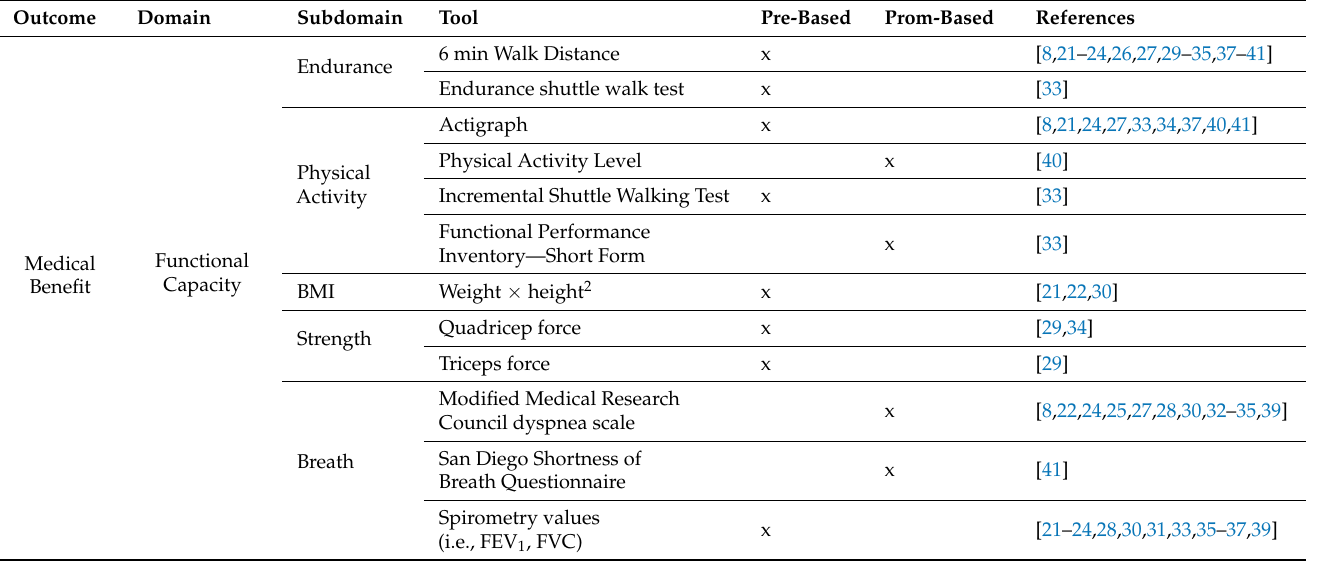
Table 4. Outcome measures of studies included in the systematic